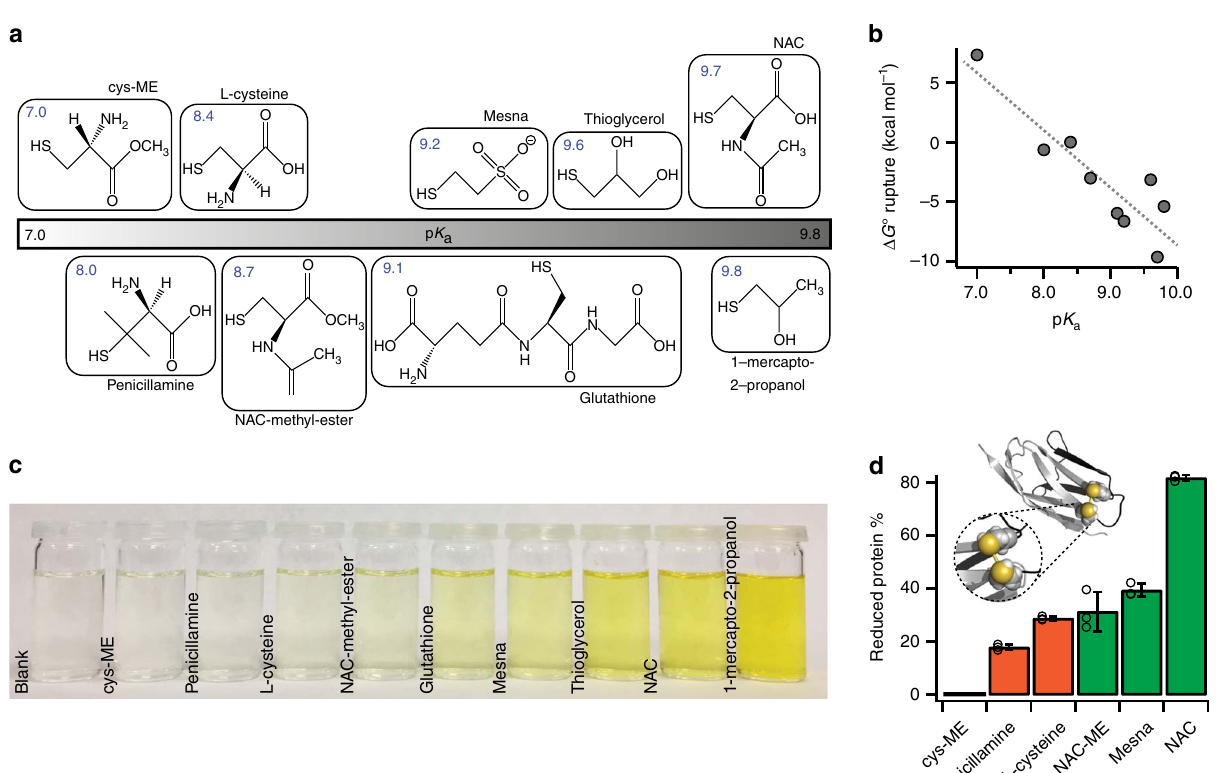
Fig. 1 Thermodynamically unfavoured disul fi de bond reduction. a The distinct physicochemical and reactivity properties of a number of small thiol-rich nucleophiles are exempli fi ed in their largely different sulfur p K a , spanning the range p K a ~7 – 10 (individual values represented on top of the chemical structures). b DFT calculations of the standard free energy (M06-2X functional with one explicit water) associated with disul fi de rupture of cystine by the different thiol nucleophiles are in good agreement with the experimentally measured p K a values. c The Ellman ’ s assay measures the reactivity of the small low molecular weight thiols in solution, displaying a reactivity trend that increases with the sulfur p K a . d Mass spectrometry experiments measure the ability of each nucleophilic thiol to reduce an individual disul fi de bond embedded within the core of a I27 E24C-K55C protein (inset) under 1:54 (protein disul fi de:active nucleophile) conditions upon acetonitrile exposure (green, thermodynamically allowed; orange, marginally allowed). The % of reduced disul fi des matches the reactivity trend observed in solution and predicted by DFT calculations. (Empty circles represent values from individual experiments, n = 3, error bars: